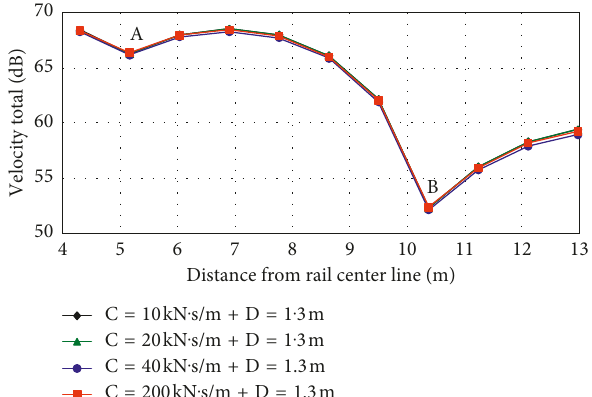
Figure 9: Finite element results for the vibration total dB (equation (8)) changing with the distance from the rail centerline under a rail pad stiffness of 1E6kN/m (where C is the rail pad damping and D is the interval of the rail pad).